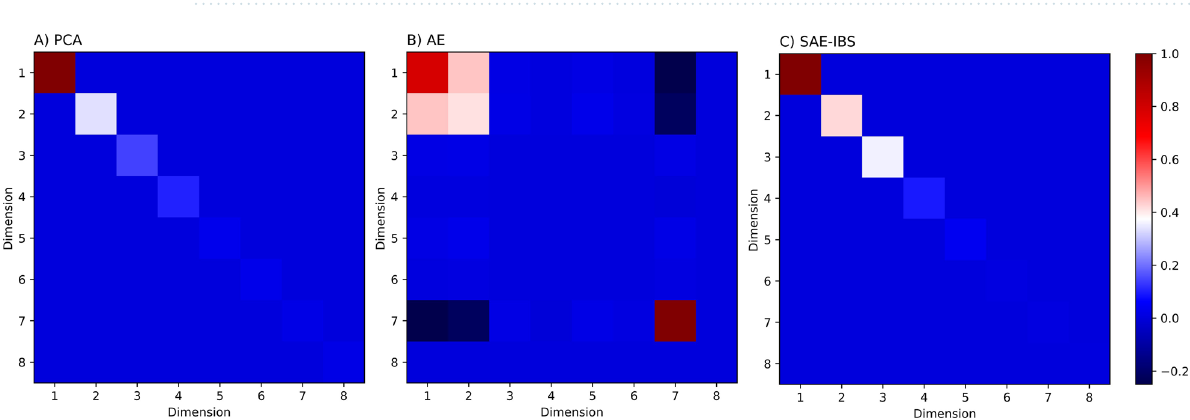
Figure 2. Comparison of the latent spaces for different methods. Scatter plots of the top two ancestry axes determined using ( A ) PCA, ( B ) AE, ( C ) SAE-IBS. The color of a point represents the ancestry of an individual, blue tints for European, green tints for African, red tints for East Asian, yellow tints for American, and purple tints for South Asian. The projected target samples from HDGP dataset onto 1KGP reference space are plotted in grey. Note in ( C ) SAE-IBS, to make the relative positions of clusters in different figures easier to compare visually, the first ancestry score was multiplied by − 1. African Caribbean in Barbados (ACB); African ancestry in the southwestern United States (ASW); Bengali in Bangladesh (BEB); Chinese Dai in Xishuangbanna, China (CDX); Utah residents with ancestry from northern and western Europe (CEU); Chinese in Beijing (CHB); Han Chinese South (CHS); Colombian in Medellín, Colombia (CLM); Esan in Nigeria (ESN); Finnish in Finland (FIN); British from England and Scotland (GBR); Gujarati Indians in Houston (GIH); Gambian in Western Division-Mandinka (GWD); Iberian Populations in Spain (IBS); Indian Telugu in the U.K. (ITU); Japanese in Tokyo (JPT); Kinh in Ho Chi Minh City, Vietnam (KHV); Luhya in Webuye, Kenya (LWK); Mende in Sierra Leone [MSL]; Mexican ancestry in Los Angeles (MXL); Peruvians in Lima, Peru (PEL); Punjabi in Lahore, Pakistan(PJL); Puerto Rican in Puerto Rico (PUR); Sri Lankan Tamil in the UK (STU); Nigeria; Toscani in Italy (TSI); Yoruba in Ibadan (YRI).